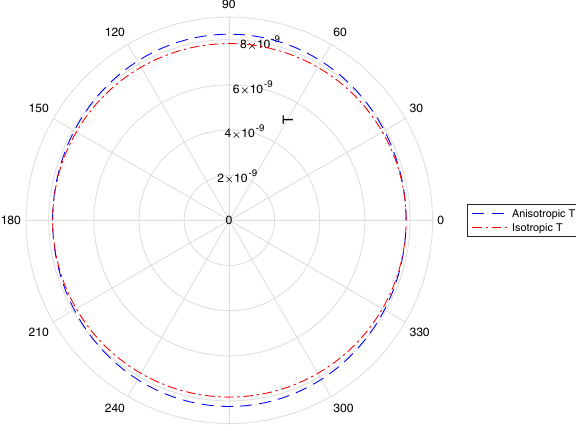
Figure 1. Variation of Transmission coefficient with angle due to anisotropic corrections. Parameter: 22 10 10 23 , a 10 19 10 21 , β 0 k 1 k 2 , β 0 x y = − = = = =